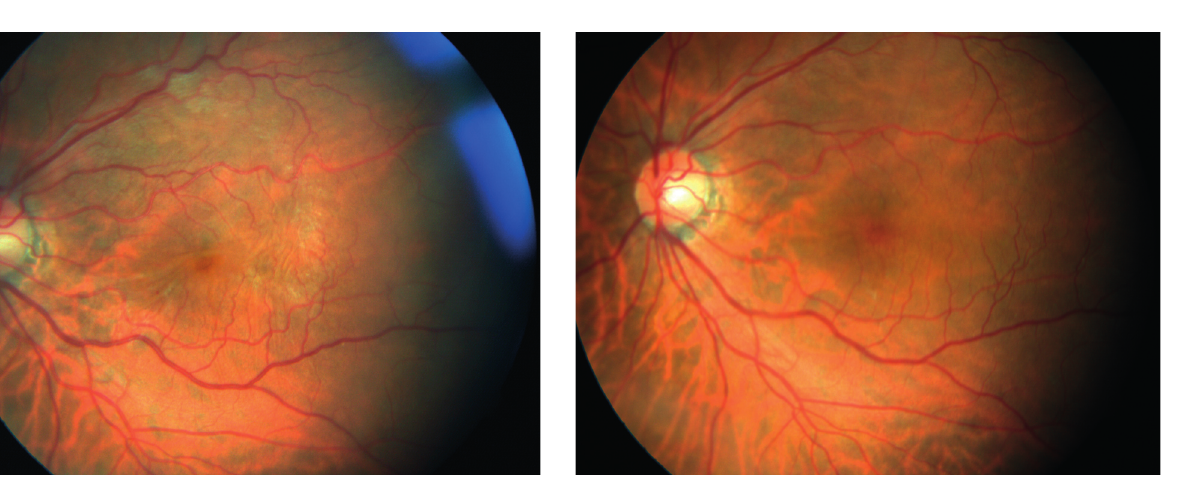
Fig. 1. High intensity of the epimacular membrane reflection and folding of the retinal internal limiting membrane.